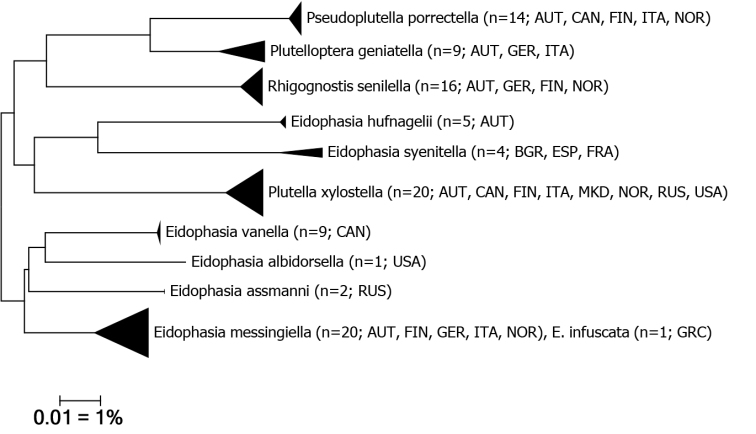
Neighbor-Joining tree (Kimura 2 parameter, built with MEGA 6; cf. Tamura et al. 2013) of Eidophasia spp. and type species of selected Plutellidae genera. The width of the triangles represents the sample size, and the depth the genetic variation within the cluster. Source: DNA Barcode data from BOLD (Barcode of Life Database, cf. Ratnasingham and Hebert 2007).